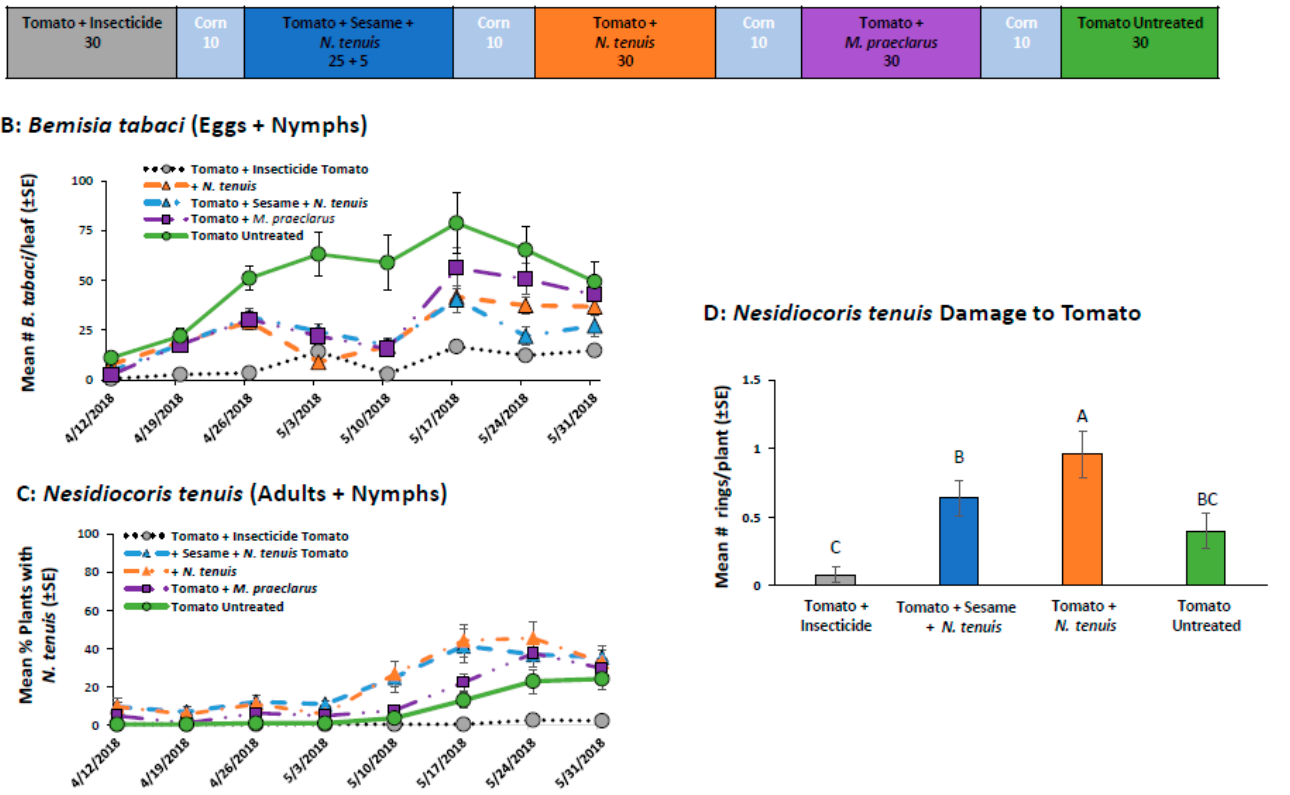
Figure 6. The field plot layout ( A ) and the mean (±SE) number of B. tabaci (eggs + nymphs) per tomato ( B ) and percentage of sesame plants with mirids ( C ) in a field study that compared insecticides, M. praeclarus and N. tenuis releases to control B. tabaci in tomato alone and in a tomato-sesame intercrop. N. tenuis invaded all mirid release plots and mirid damage measured as the mean (±SE) number of necrotic rings ( D ) was caused by N. tenuis . The number under each field plot treatment ( A ) indicates the number of tomato and sesame plants .